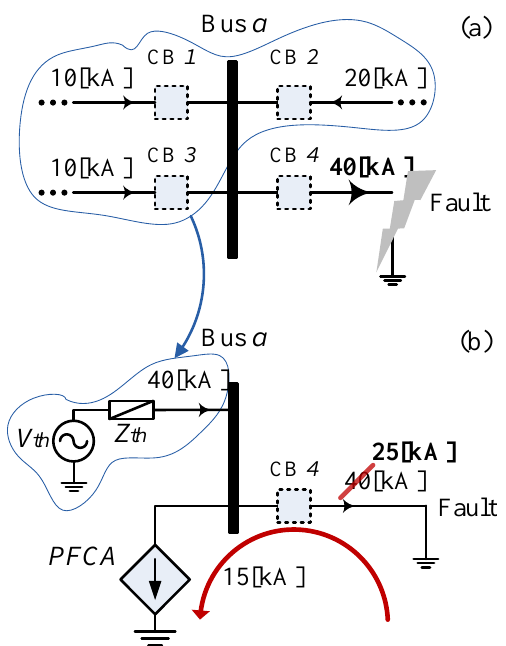
Figure 3. Numerical comparative for a three-phase fault in a branch and its impact on SCC: ( a ) without the PFCA; ( b ) with the PFCA.